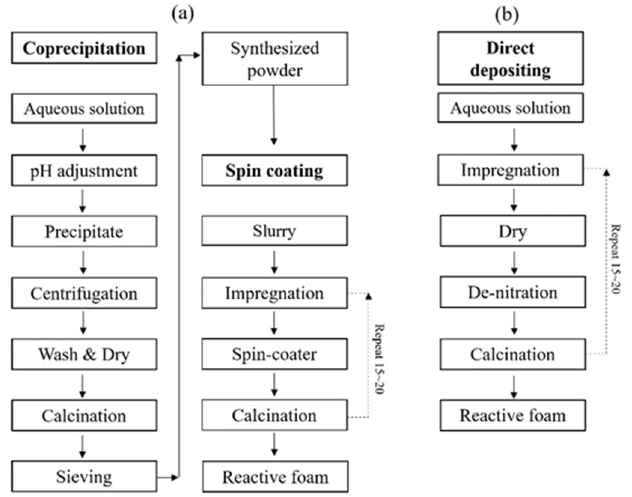
Figure 2. Schematic diagram of synthesis of Mn-CeO 2 and fabrication of Mn-CeO 2 coated foam devices: ( a ) synthesized by coprecipitation method and spin coating process, ( b ) direct depositing method.